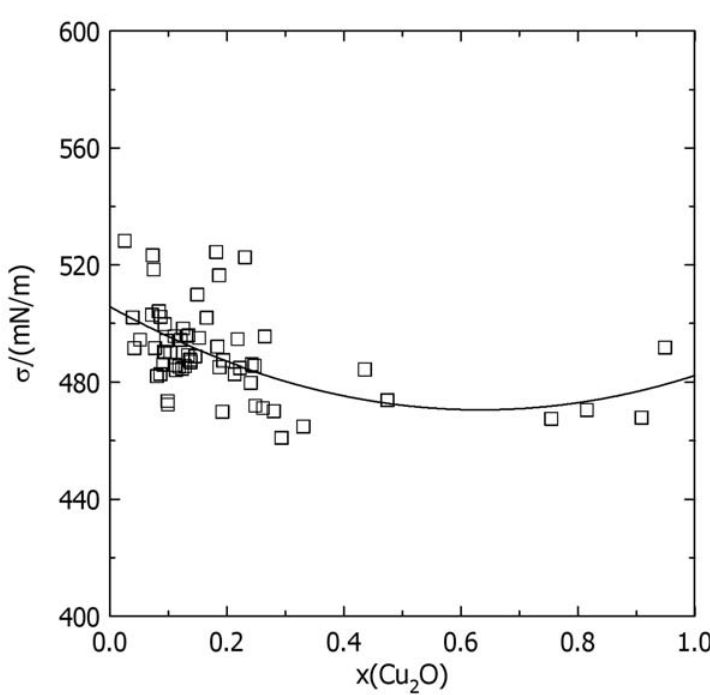
Fig. 6 Dependence of the surface tension of melts of the system CaO-Fe 2 O 3 -Cu 2 O on the content of Cu 2 O at the temperature of 1573